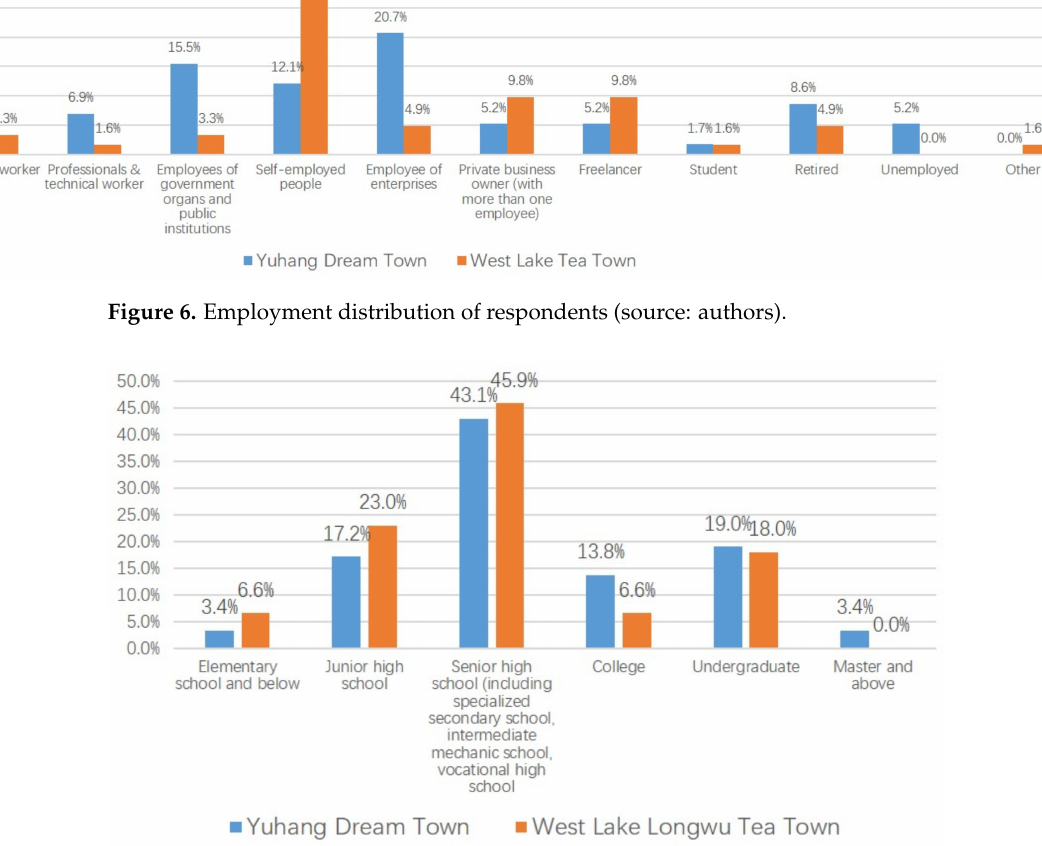
Figure 7. Educational background distribution of respondents (source: